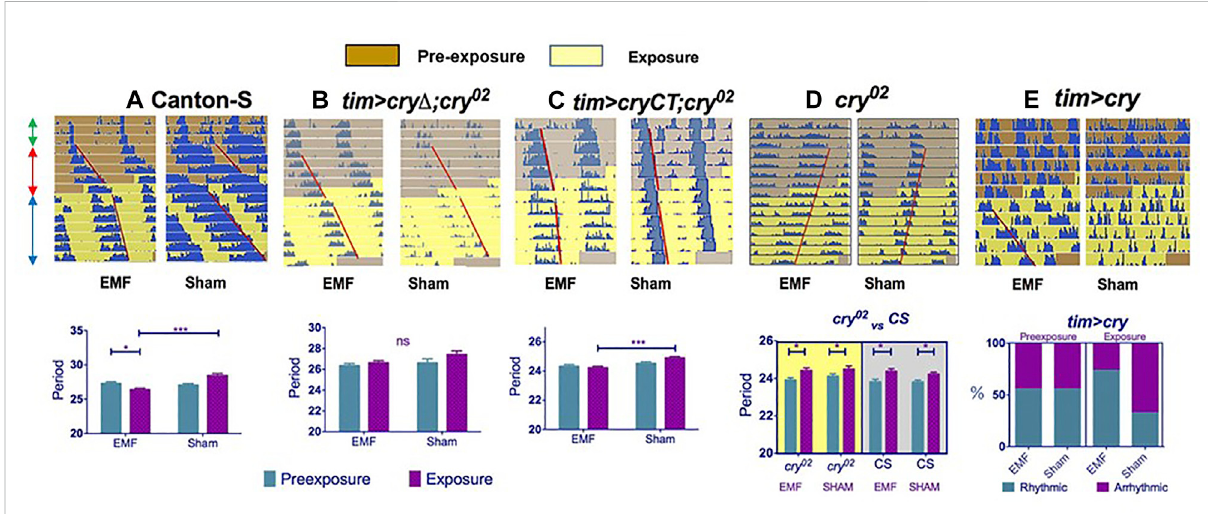
FIGURE 2 Exposure to a low frequency magnetic fi eld has a circadian phenotype in Drosophila . Top row (A – E) : double plotted representative actograms from a male fl y from each genotype. The left hand actogram for each genotype shows the activity of a fl y exposed to a MF, whereas the right hand panel shows the activity under sham exposure. Each row of the actogram shows 2 days of activity day1 and day2, below which is represented day2andday3,thenday3 days4andsoon.The doubleheadedgreenarrowsontheleftofpanelAshow the fi rst3 days inadimbluelight-dark BLD12:12 cycle, followed by 5 days in constant dim blue light, BLL (prexposure, red arrows, brown background on actogram), followed by 8 days in thesame BLL conditions but with exposure (orsham) to a 3 Hz, 300 μ T MF (blue arrows, yellow background). Red lines show offsets of free-running locomotor activity re fl ecting any change in period after exposure. (A – C) The graphs below show the corresponding mean free-running period and sems for each genotype calculated from the pre-exposure and exposure conditions in the sham and experimental groups. (A) : Canton-S